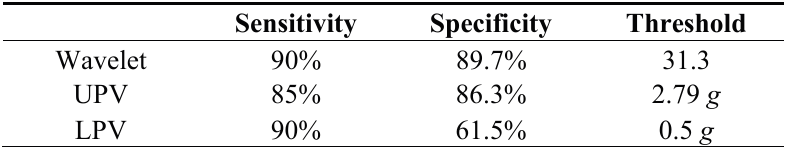
Table 2. Combination of sensitivity and specificity with the maximum Youden’s Index and corresponding threshold for the three